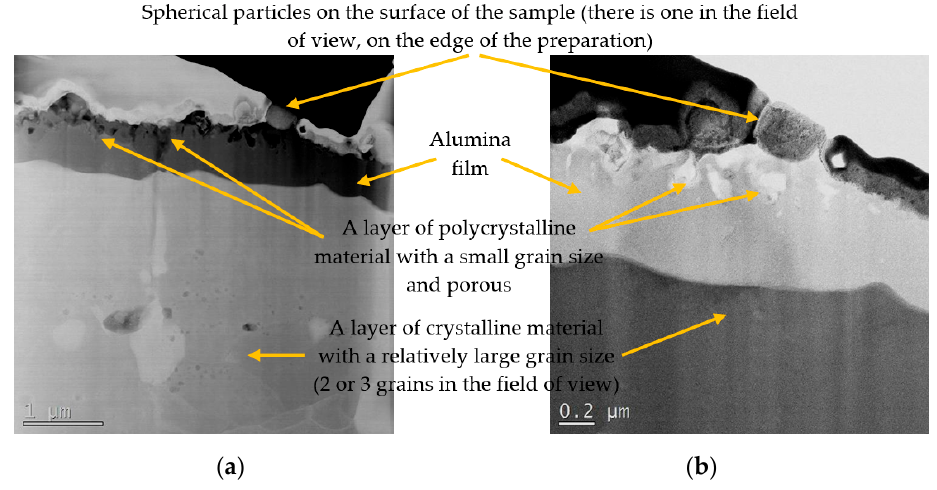
Figure 6. Cross-section of the coating exposed to 1150 °C, imaged with HR STEM, employing: (a) Z—contrast; ( b ) TE—contrast.